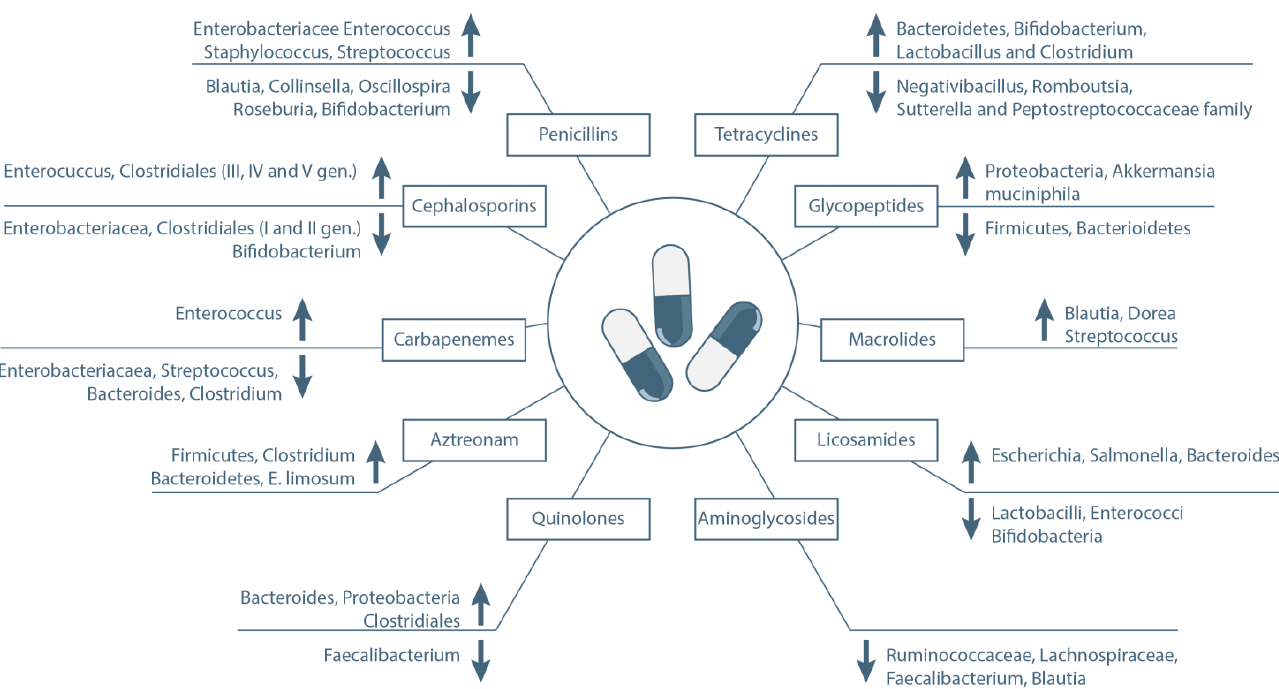
Figure 2. Impact of main antibacterial molecules on clinically relevant gut bacterial